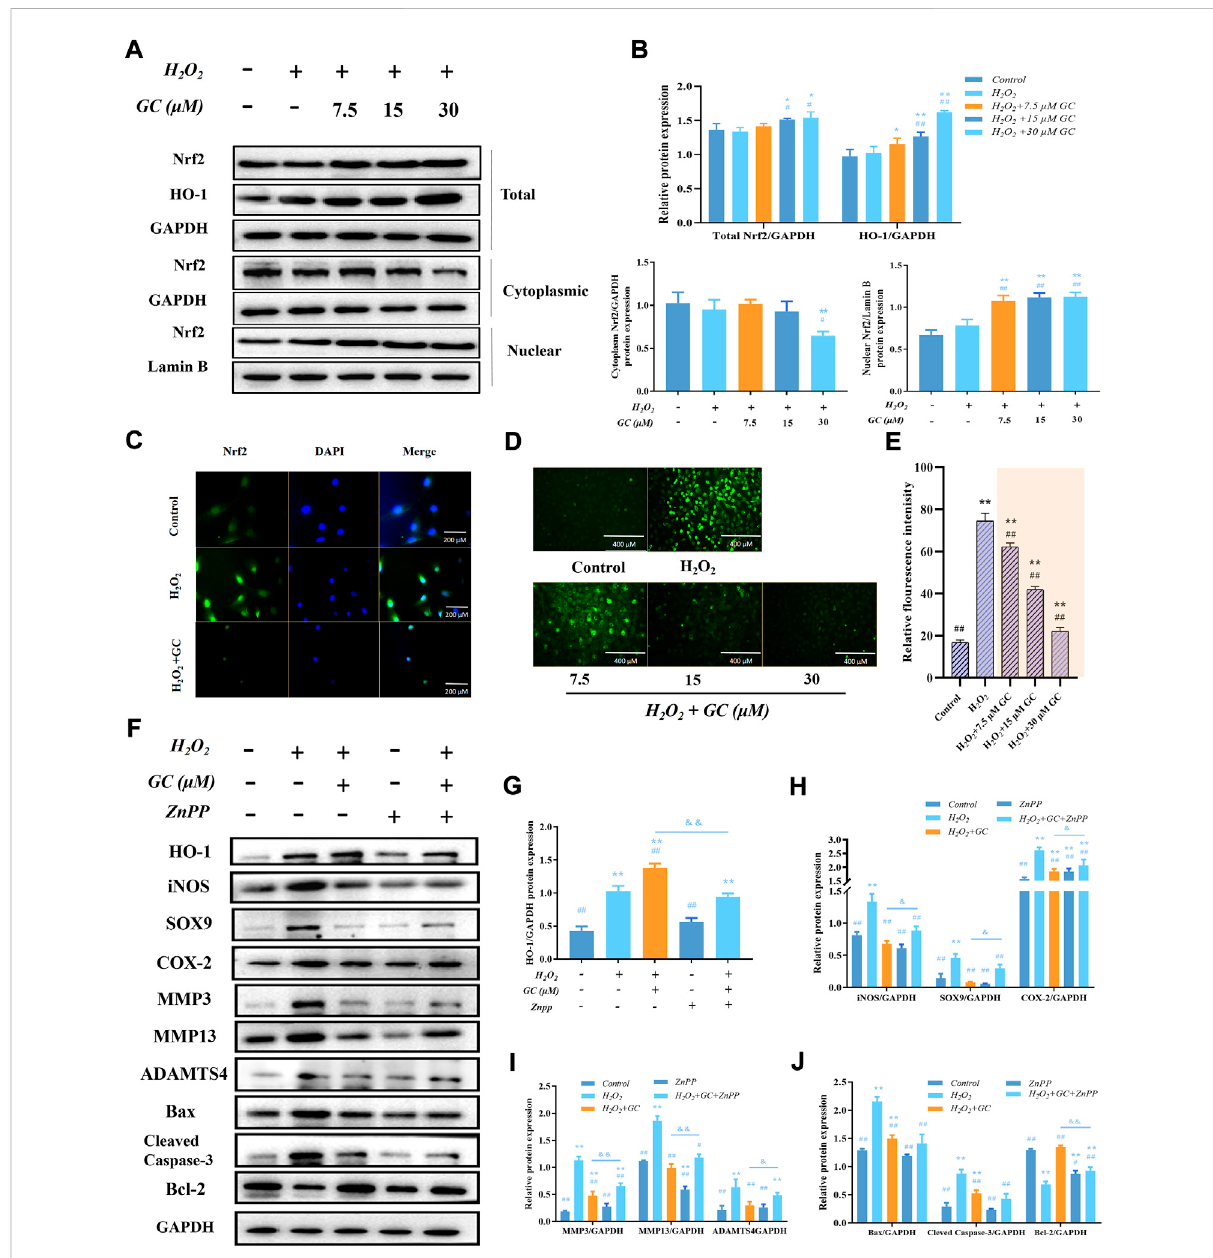
FIGURE 3 TheexpressionofHO-1inchondrocytesthathavebeen exposedtoH 2 O 2 islinkedtotheanti-apoptoticandanti-chondraldegrading effectsof GC. (A and B) Western blot images and quanti fi cation information for the protein expression of the Nrf2/HO-1 signaling pathway in each group following the aforementioned treatment. (C) Immuno fl uorescence detection of nuclear translocation of Nrf2 protein with DAPI staining for nuclei. 200 µmscalebar. (DandE) Dichlorodihydro fl uoresceindiacetate(DCFH-DA) fl uorescentstaining showed that GCinhibited theH 2 O 2 induced ROS production. 400 µm scale bar. (F – J) Western blot imaging and quanti fi cation data for each group treated with H 2 O 2 , GC, and 10 μ M Zinc (II) Protoporphyrin IX (ZnPP) for HO-1, iNOS, SOX9, COX-2, MMP3, MMP13, ADAMTS4, Bcl-2, Bax, and Cleved-caspase 3. All data are presented as mean±SD(n=3).* p < 0.05and** p < 0.01 vs. controlgroup; # p < 0.05and ## p < 0.01 vs. H 2 O 2 group; ＆ p < 0.05and ＆＆ p < 0.01vs.H 2 O 2